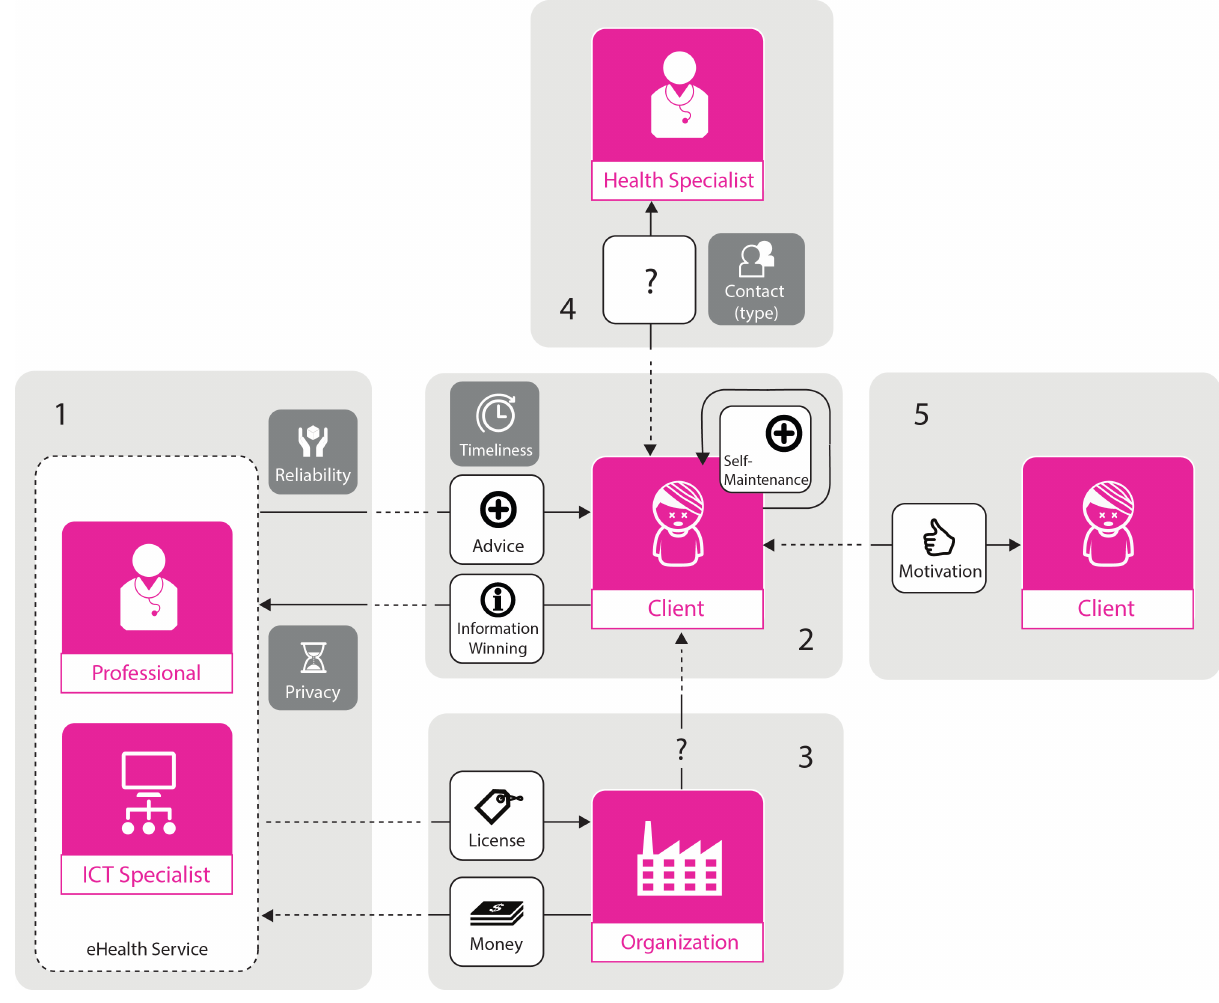
Figure 6. The five building blocks integrated in the business model design for eHealth services in precare. ICT: information and communication